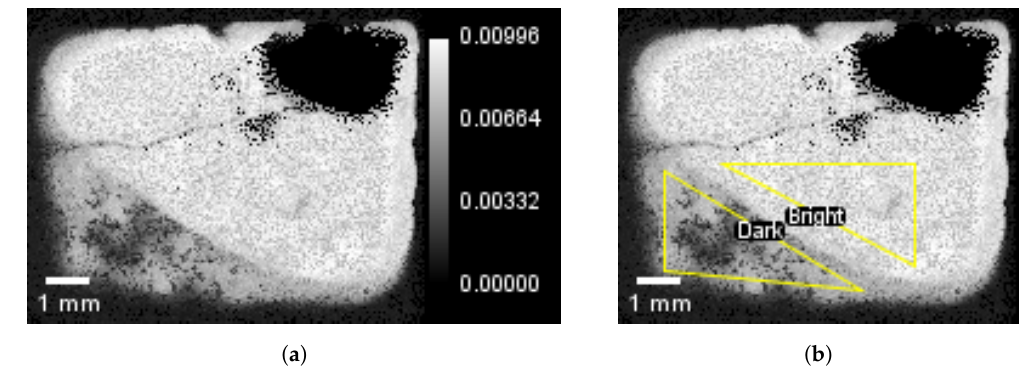
Figure 8. HFIR CG-1D open beam neutron response image. ( a ) open beam response; ( b ) open beam intensity ROI.